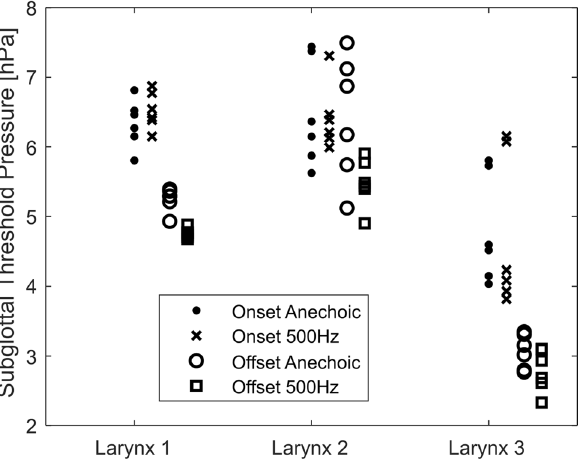
Figure 5. Oscillation threshold pressure for each larynx with an anechoic subglottal tract and resonant tract set to 500 Hz subglottal resonance. Each point corresponds to one flow sweep. Notice the onset thresholds are generally higher than the offset thresholds. The subglottal acoustics had little influence on the onset pressures (dots versus crosses), but the offset pressures were significantly lower for the resonant subglottal tract (circles versus squares). For the numerical values and the statistical results, see the Supplementary material S1 to this